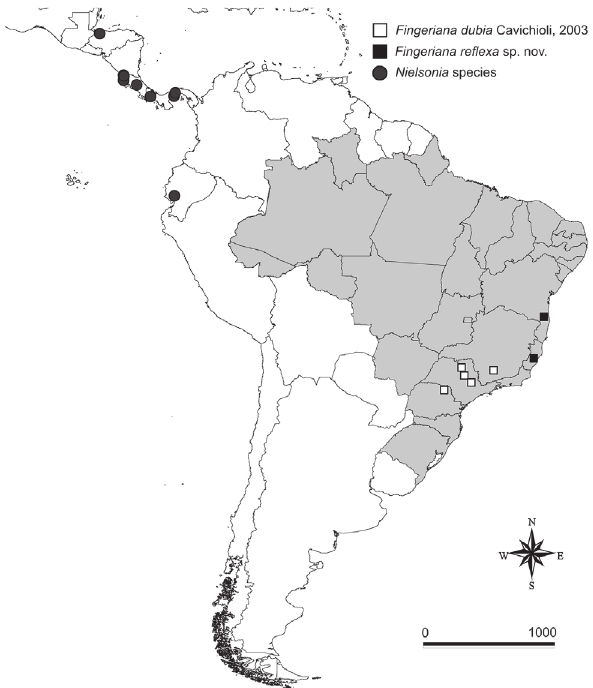
Figure 7. Known distribution of the species of Fingeriana and Nielsonia